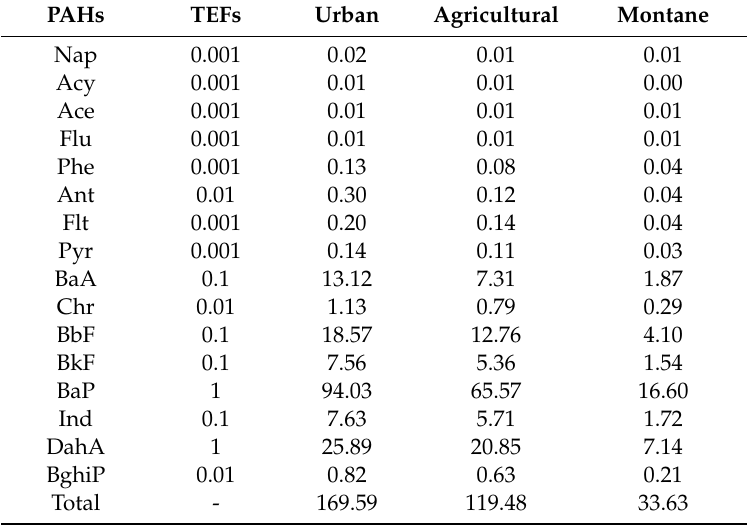
Table 2. BaP toxic equivalent concentration (BaP eq ) concentration of 16 PAHs in soils from Taiyuan. PAHs TEFs Urban Agricultural Montane Nap